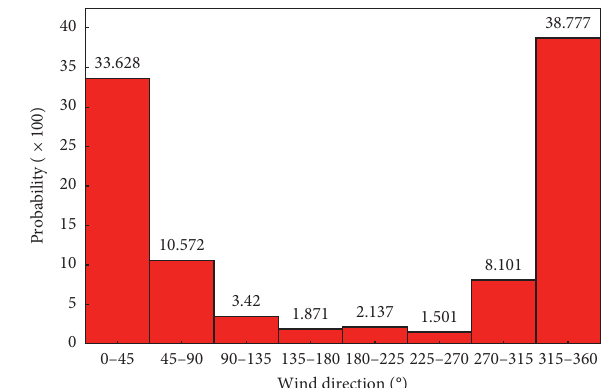
Figure 8: Wind direction data in West Africa Sea.